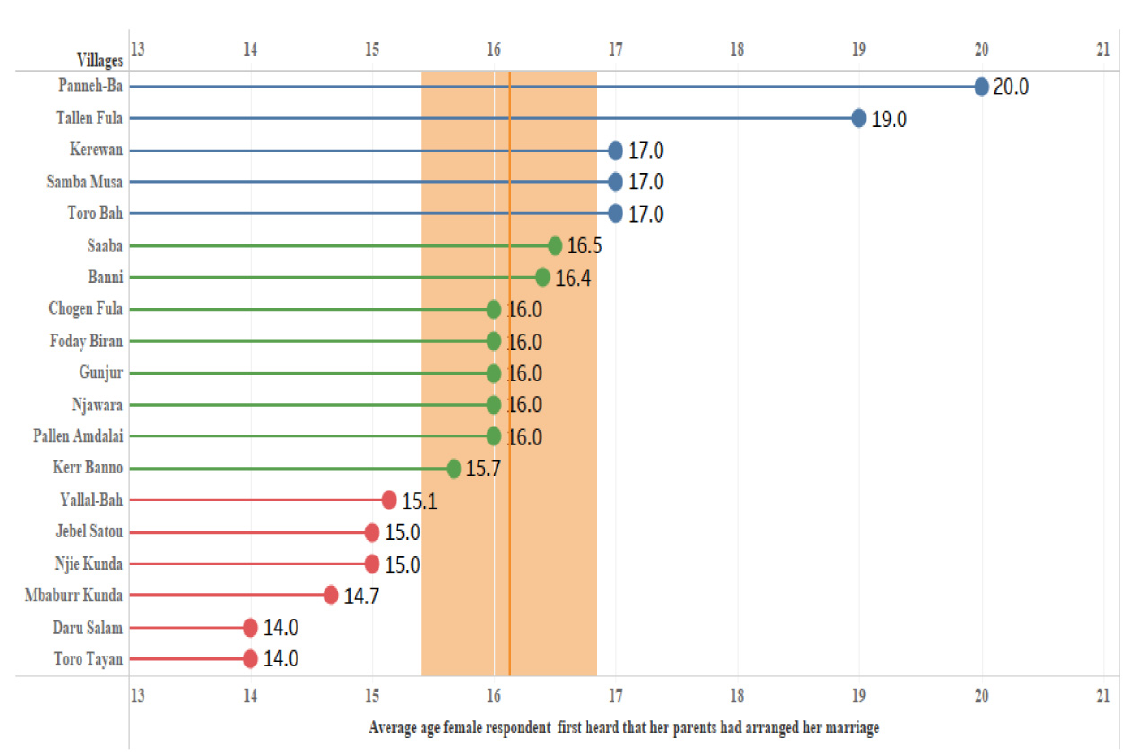
the Mandinka ethnic group indicates that part of the effect observed in Model 1 was explained by the socioeconomic condi- tion of the family and was not an effect of the Mandinka ethnic group by itself. On the other hand, the result of the Wolof ethnic group indicates that independent of the socioeco- marrying